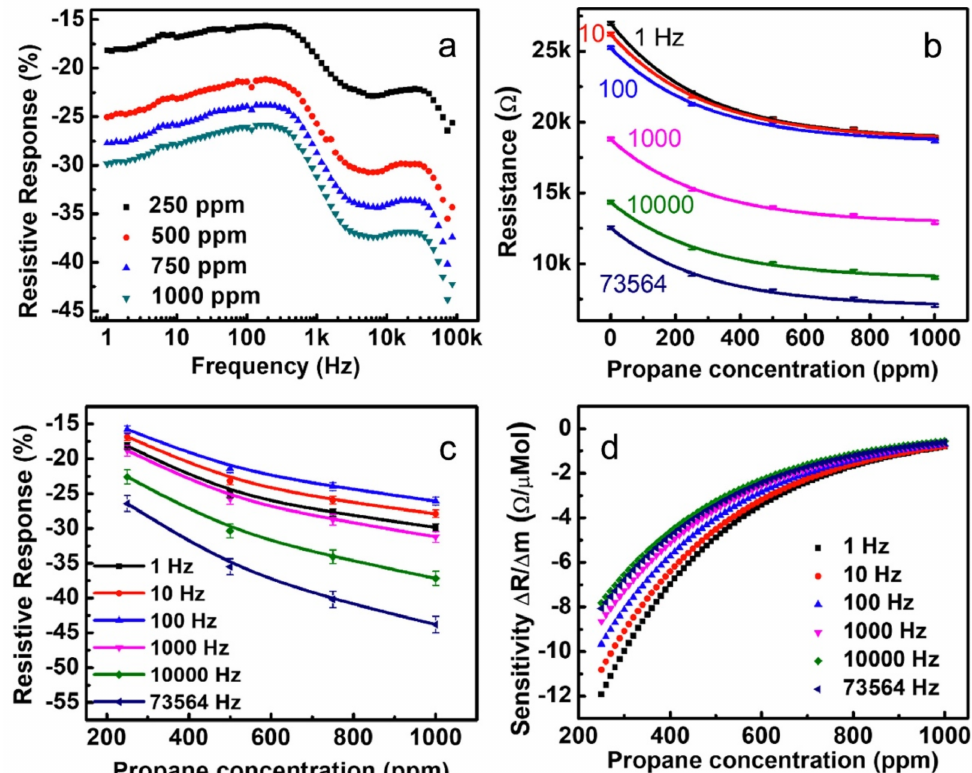
Figure 25. ( a ) Resistive response vs. frequency for different propane concentrations. ( b ) Experimental resistance values replotted as a function of the propane concentration. The solid line corresponded to the exponential fitted line to the experimental data. ( c ) The resistive response towards different concentrations of propane in different frequencies. ( d ) The sensitivity of the device as of different con- centration of propane for the selected frequencies. Reprinted with permission from [82]. Copyright 2010,